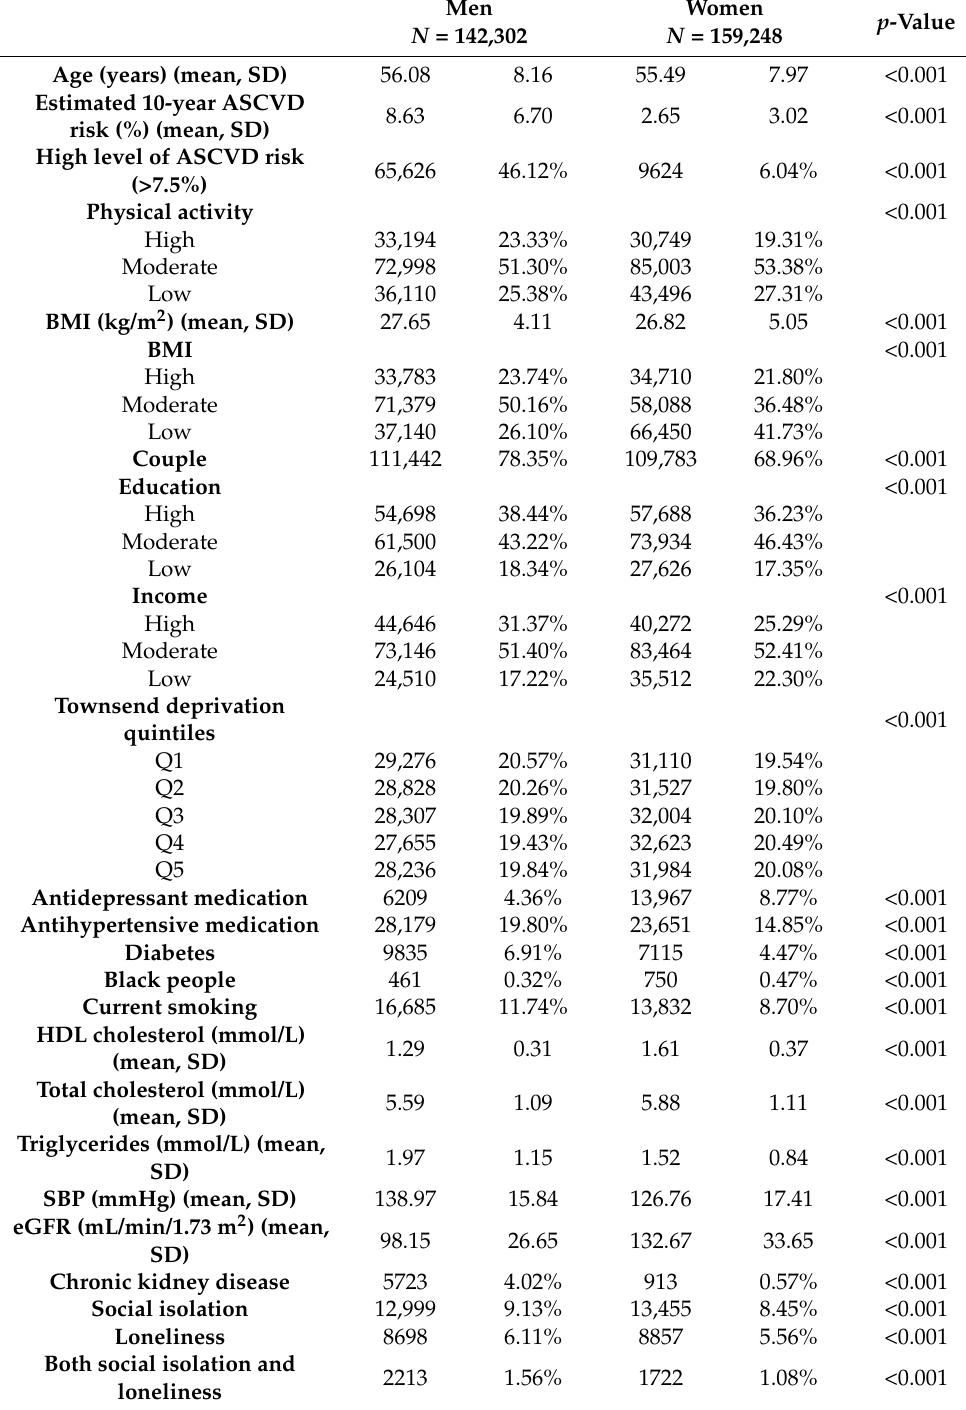
Table 1. Characteristics of the study population according to